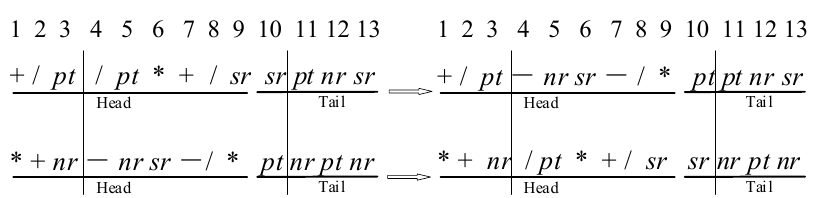
Figure 4. Two-point Recombination.